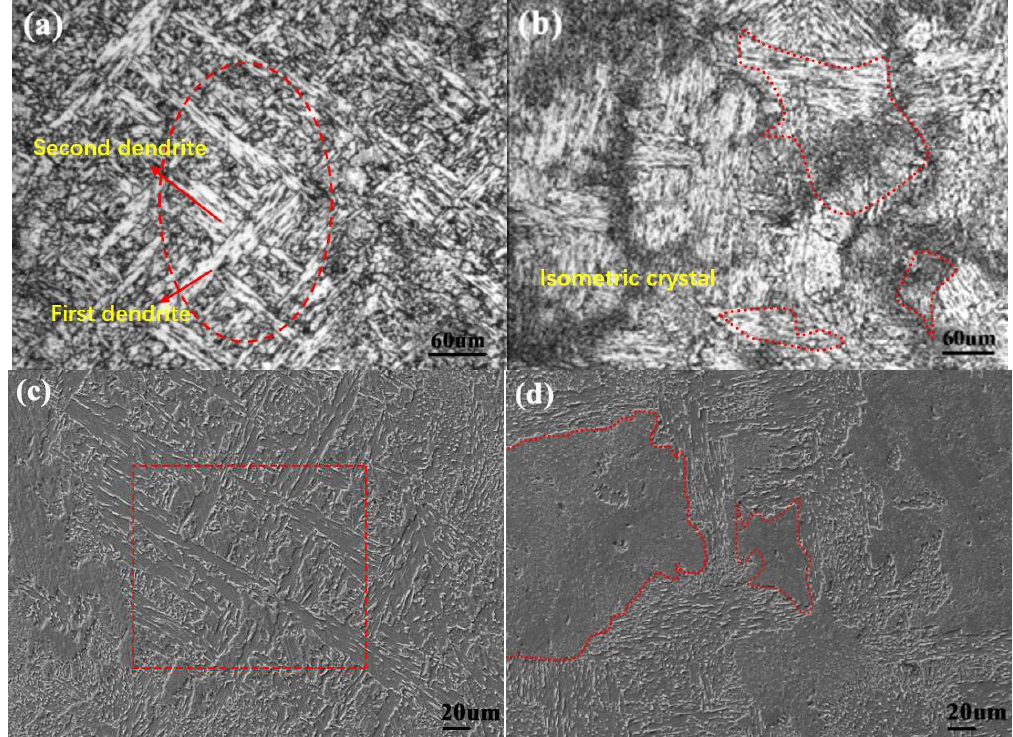
Figure 7. ( a , c ) The as-cast microstructure without dispersed in-situ nanoparticles; and ( b , d ) The as-cast microstructure with dispersed in-situ nanoparticles in high-strength steel.